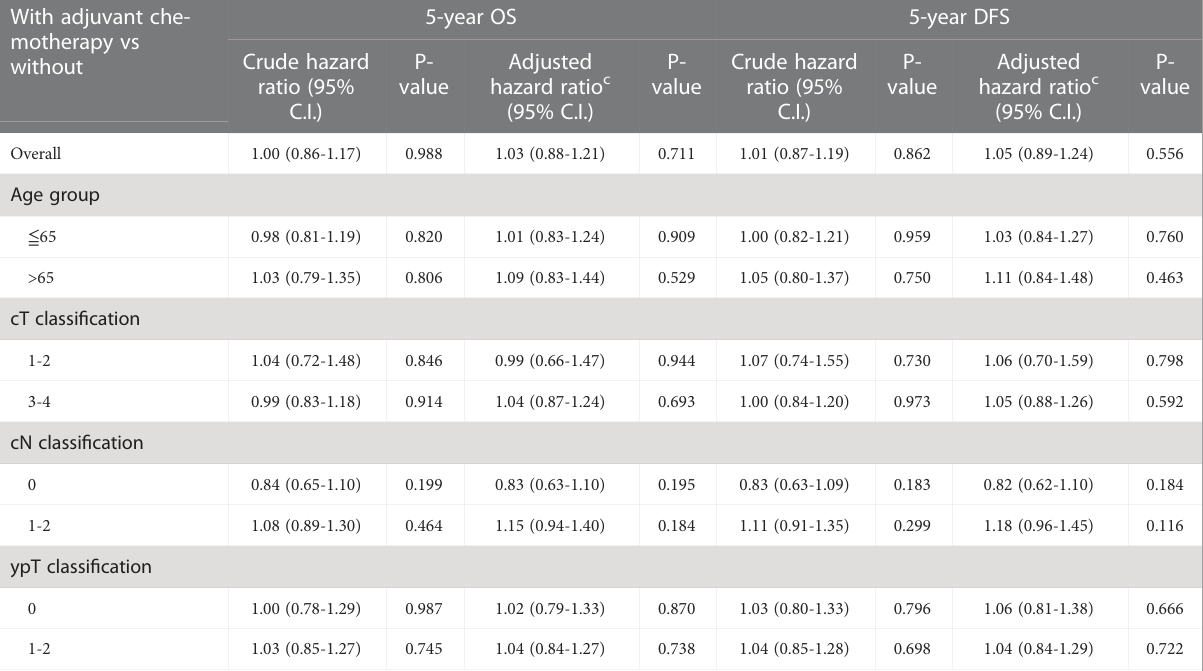
TABLE 2 Overall and strati fi ed analysis of the use of adjuvant chemotherapy for 5-year OS and DFS in rectal cancer patients with good response (ypT0-2N0) after nCRT and surgery, n=720. With adjuvant che- motherapy vs without